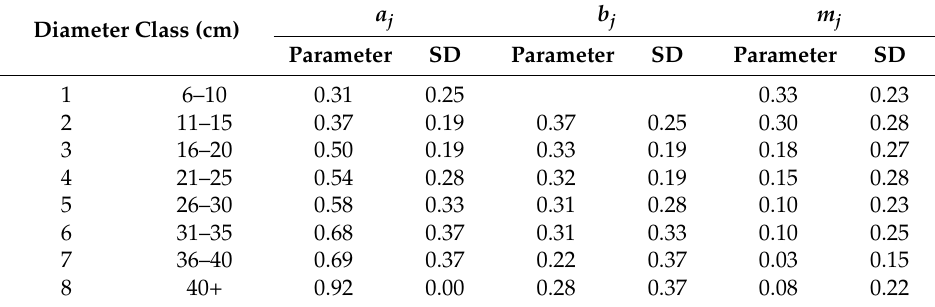
Table B1. Transition probabilities.